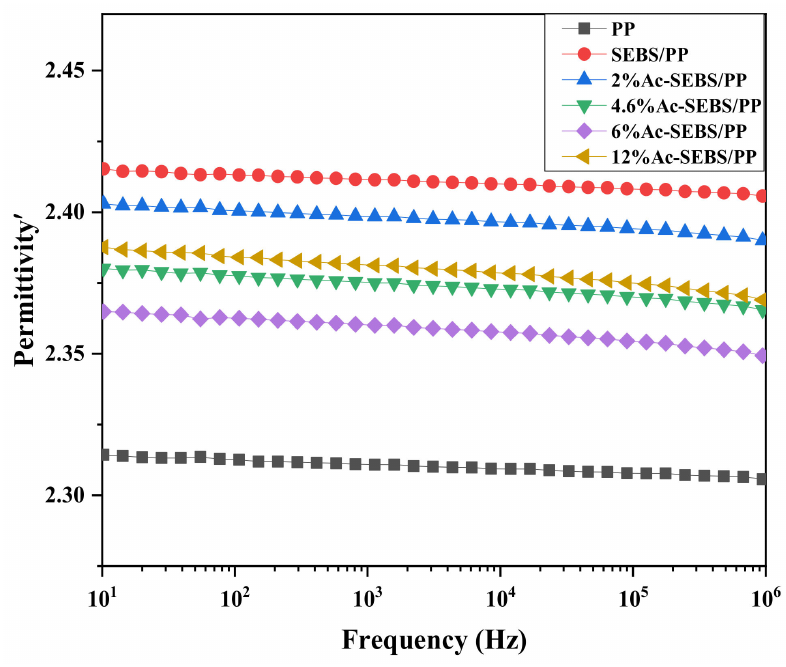
Figure 10. The dielectric constant spectrum of PP and its composites.